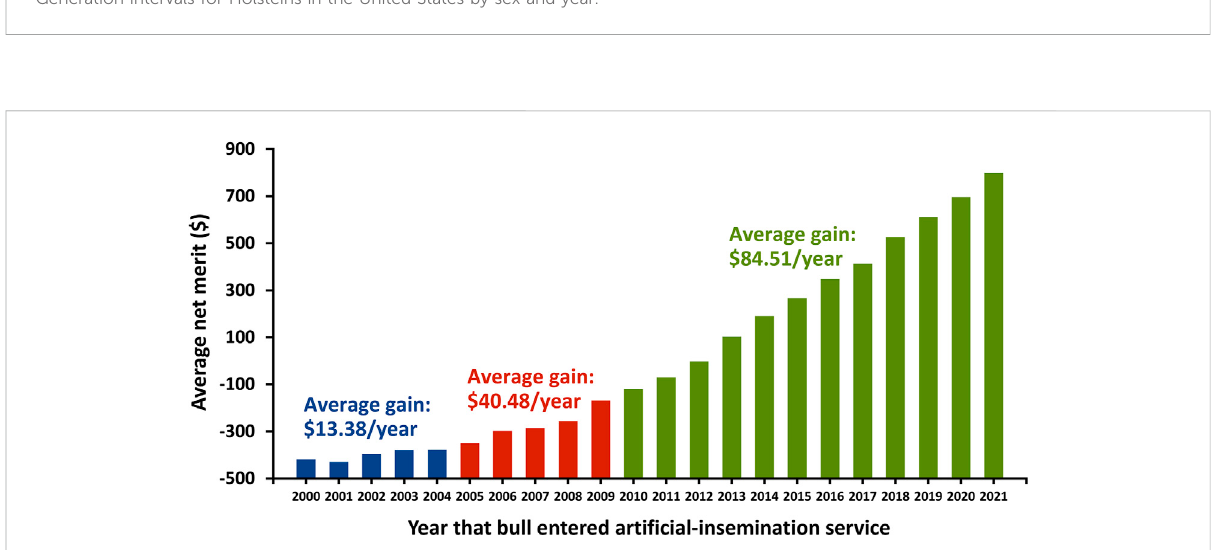
FIGURE 5 Generation intervals for Holsteins in the United States by sex and